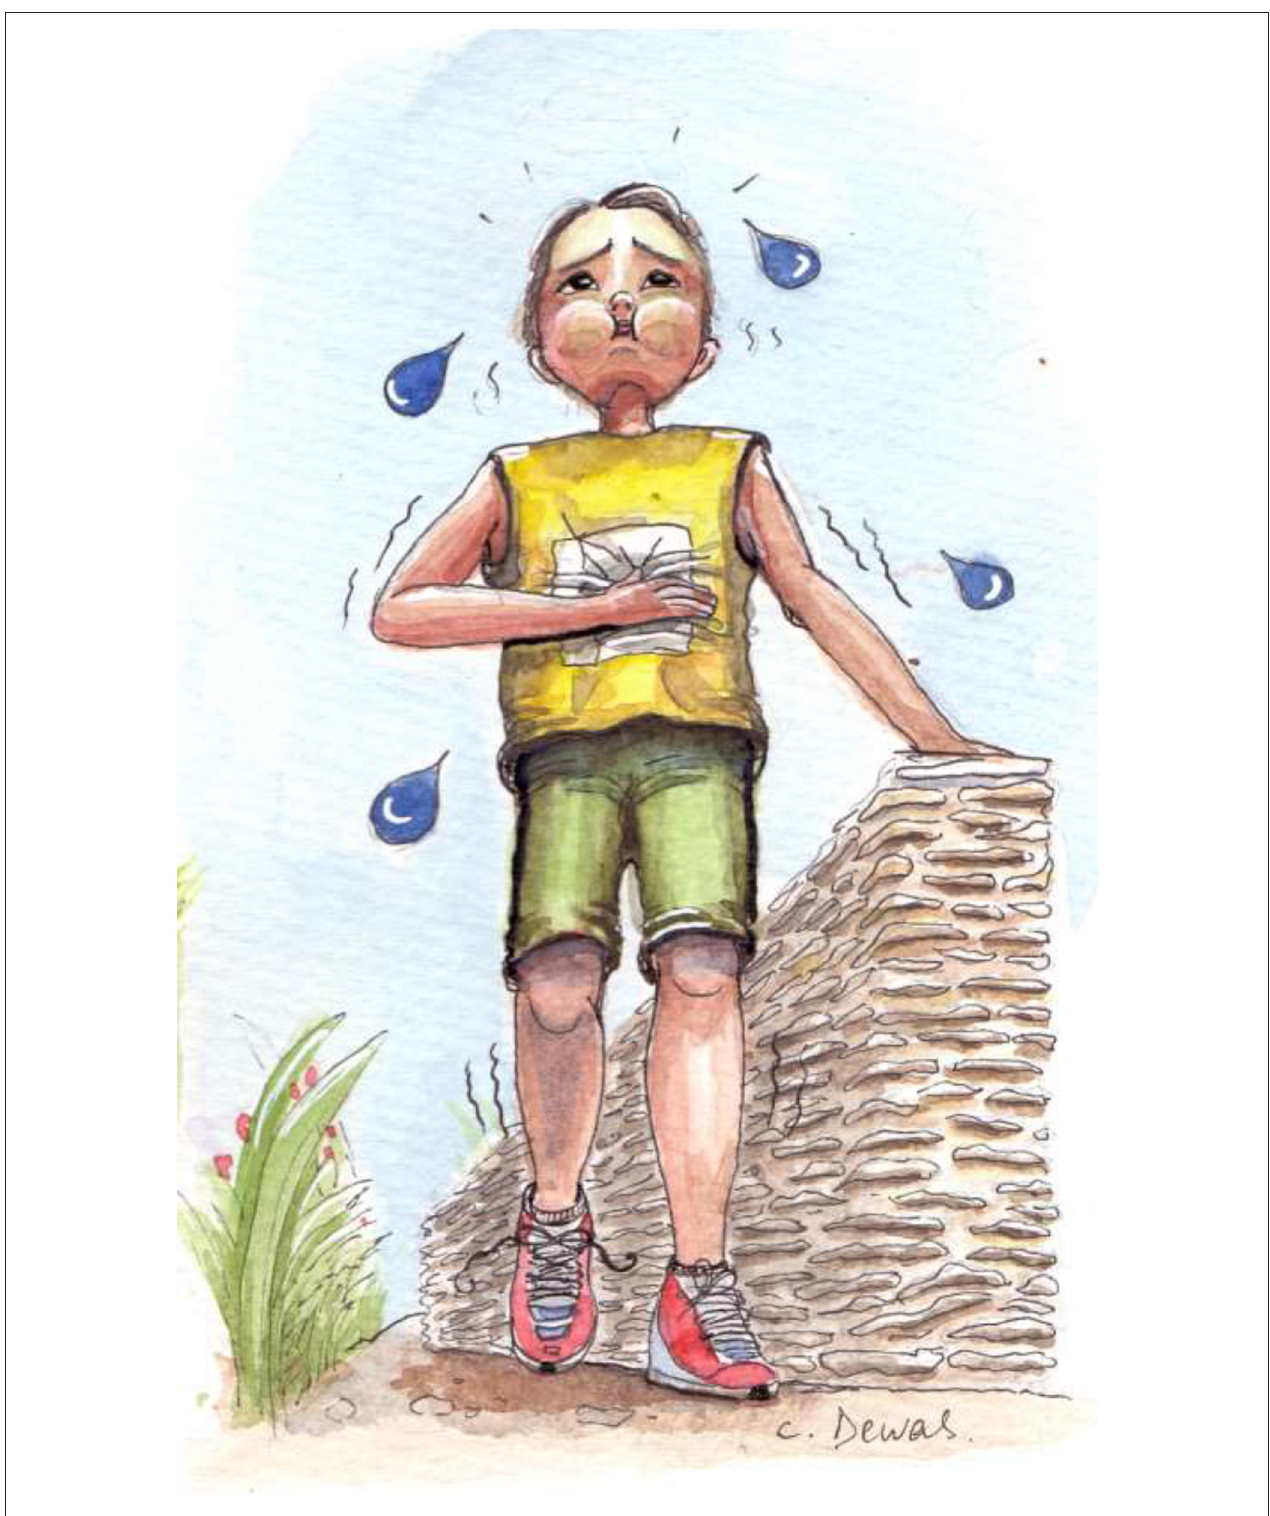
FIGURE 5 | Nausea is the most frequently mentioned digestive problem in ultra-marathon runners. Figure by Céline Dewas.